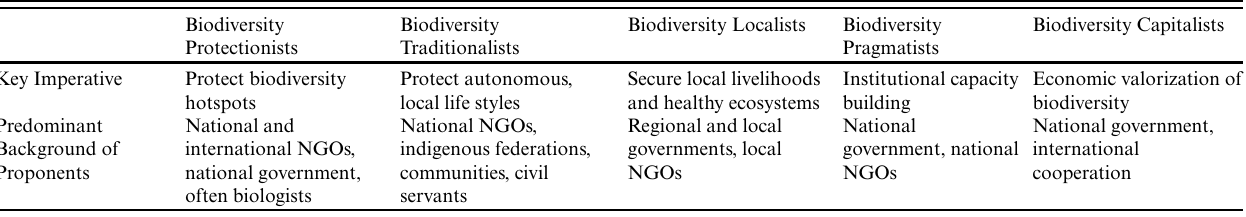
Table 2 . Presentation of narrative groups. The groups are characterized according to the general orientation and the background of proponents, who predominantly apply the respective